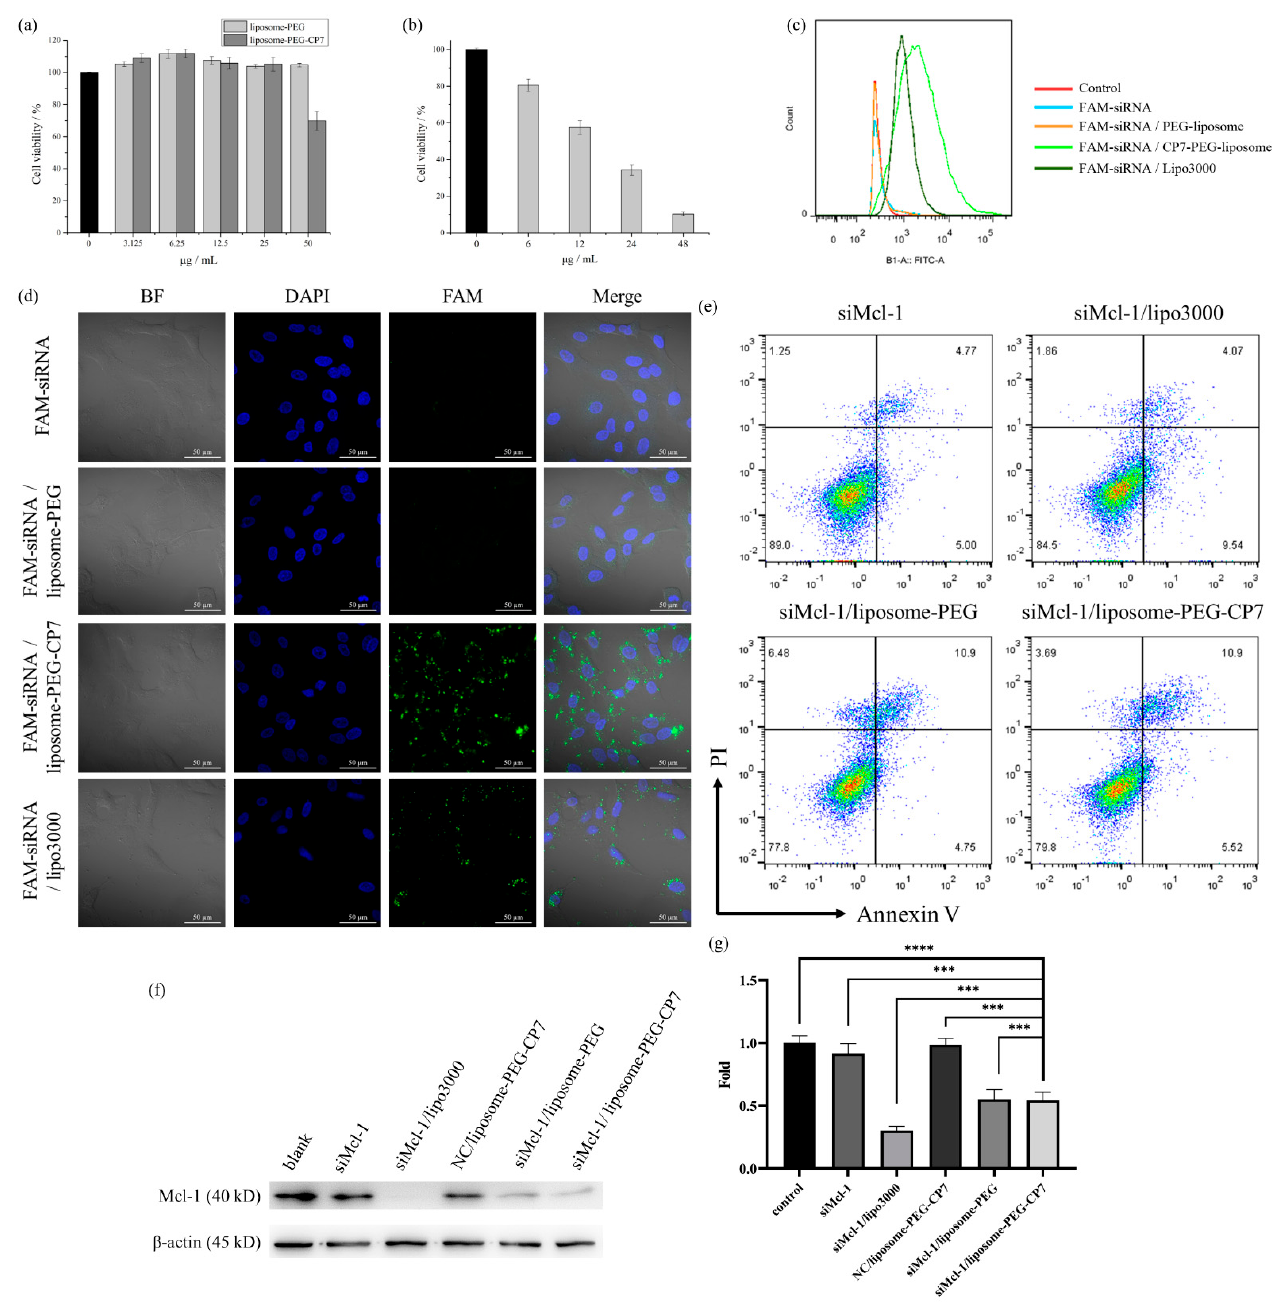
Figure 4. ( a ) Cytotoxic effect of liposome-PEG and liposome-PEG-CP7 on HFL-1 cells. ( b ) Cytotoxic effect of siMcl-1/liposome-PEG-CP7 on A549 cells. ( c ) Cell uptake of siRNA/liposomes on A549 cells determined with FCM. ( d ) Cell uptake and intracellular distribution of siRNA/liposomes in A549 cells determined with CLSM. ( e ) Apoptosis induction by siRNA/liposomes in A549 cells determined with FCM. ( f ) Level of Mcl-1 protein expressed in A549 cells treated with siRNA/liposomes deter- mined with Western blot technique. ( g ) Level of Mcl-1 mRNA expressed in A549 cells treated with siRNA/liposomes determined with RT − PCR. *: differences between siMcl-1/liposome-PEG-CP7 with other groups, ***: p < 0.001, ****: p < 0.0001.